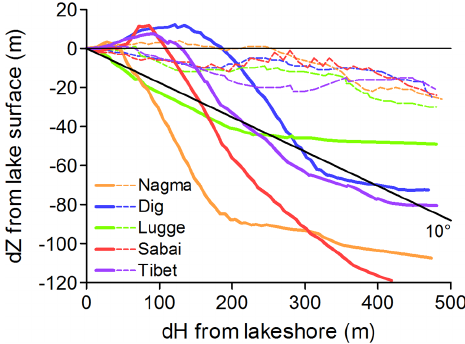
Fig. 6. Pre-GLOF (thick lines) and post-GLOF (thin dashed lines) cross-sections along the outlet of five training glacial lakes in the Himalayas (Fig. 5; Table 1). Horizontal and vertical axes denote horizontal distance from the lakeshore (dH) and relative elevation from the lake surface (dZ), respectively. Also shown is a black line along the threshold angle of 10 ◦ . Lake “Tibet” denotes the unnamed lake in Tibet. Note that the lakeshores (dH = dZ = 0) are not at the same location in the pre- and post-GLOF